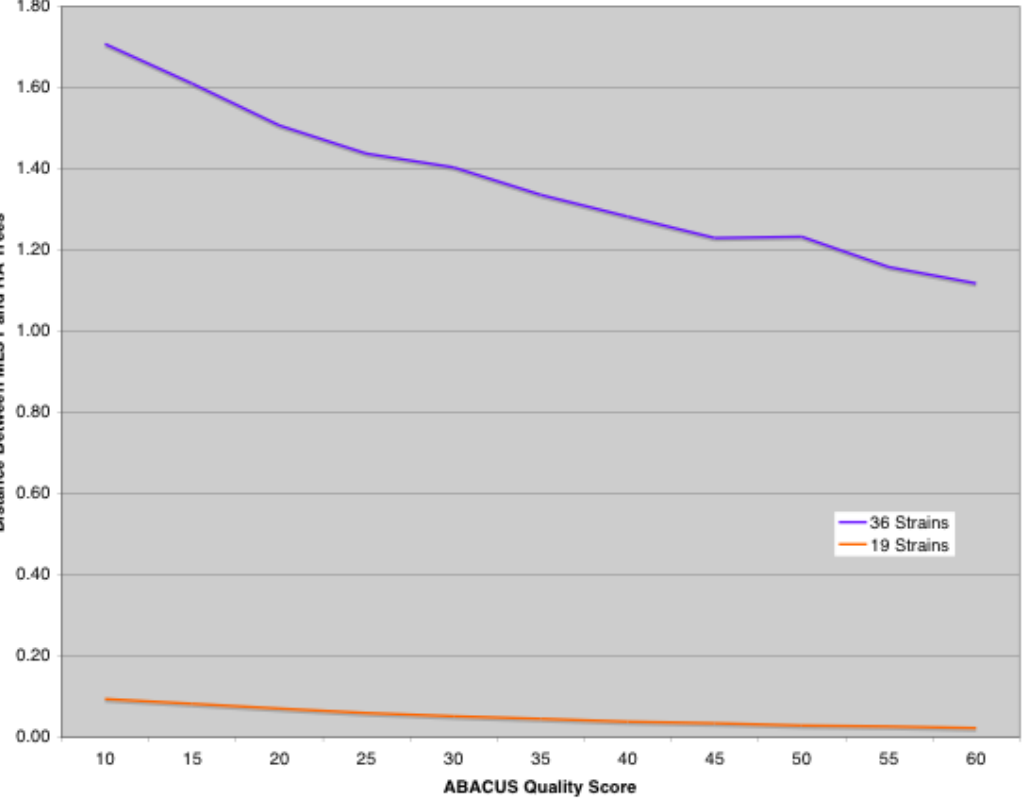
Figure 2. Graphs showing resequencing array (RA) percent basecalling at different ABACUS quality score (QS) thresholds. The black line in each plot shows the basecalling rate for the B. anthracis Ames strain that acted as the reference sequence for the design of the RA. The raw data for this figure is contained in Table S5.